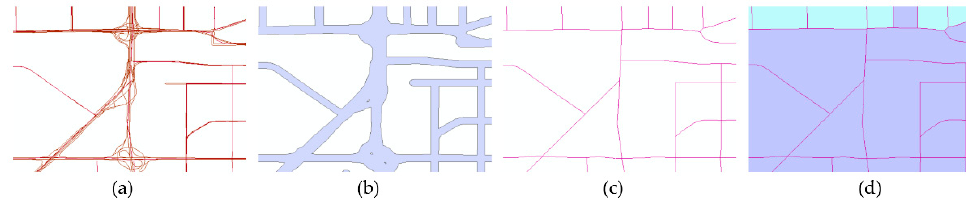
Figure 4. Construction steps of Parcels: ( a ) original road network; ( b ) roads after expansion operation; ( c ) roads by refined operation; ( d ) Parcel schematic diagram.